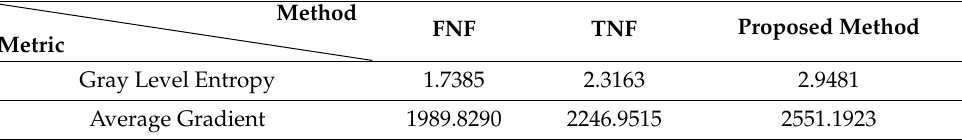
Figure 14. The RFI mitigation results for the SAR data containing RFI with multiple sources: ( a ) FNF; ( b )TNF; ( c ) the proposed method. Table 4. Gray level entropies and the average gradients after FNF, TNF, and the proposed method (multiple